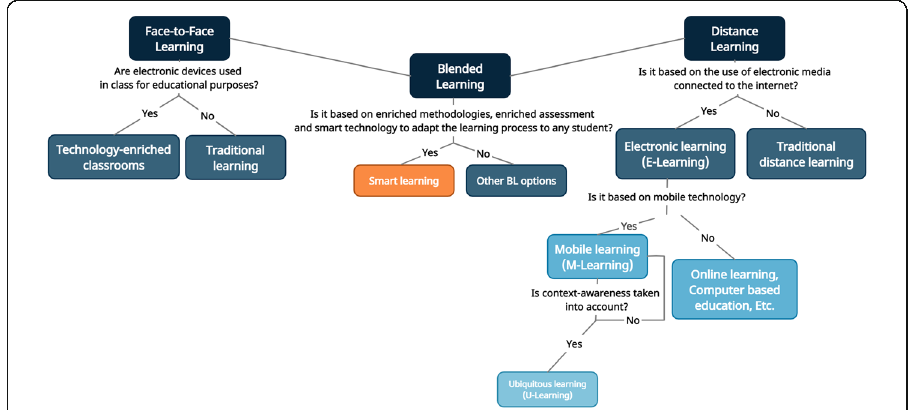
Fig. 1 Concept map on different concepts related to technology enhanced